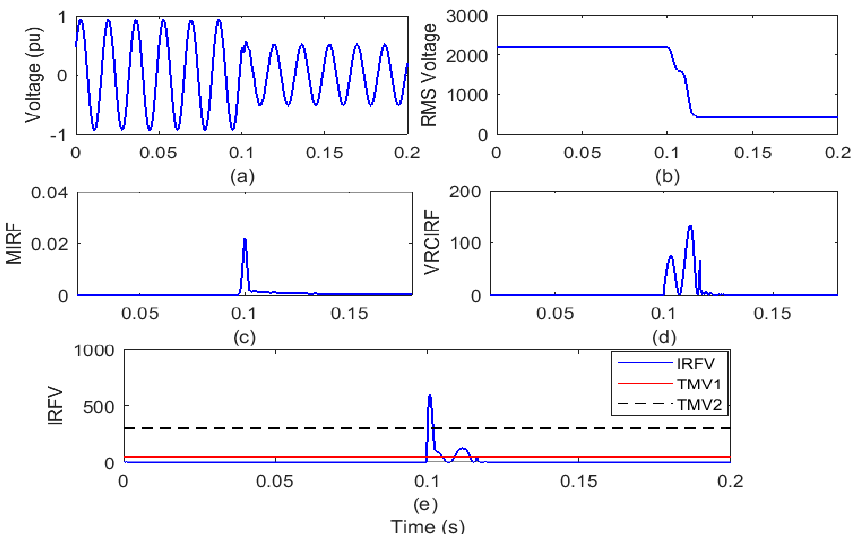
Figure 7. Single-phase-to-ground fault ( a ) voltage signal ( b ) root means square value of voltage ( c ) median-based IRF ( d ) rate of change in voltage-based IRF ( e ) islanding recognition factor based on voltage.